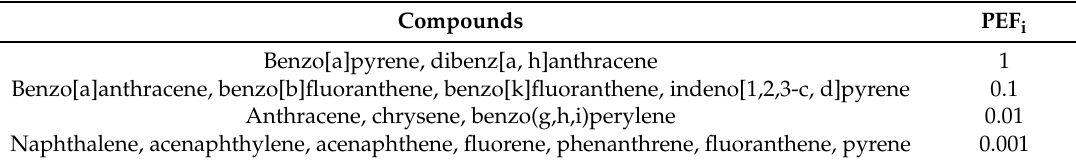
Table 3. Potency equivalency factors (PEF) for individual PAHs relative to BaP used in this study. Compounds PEF i